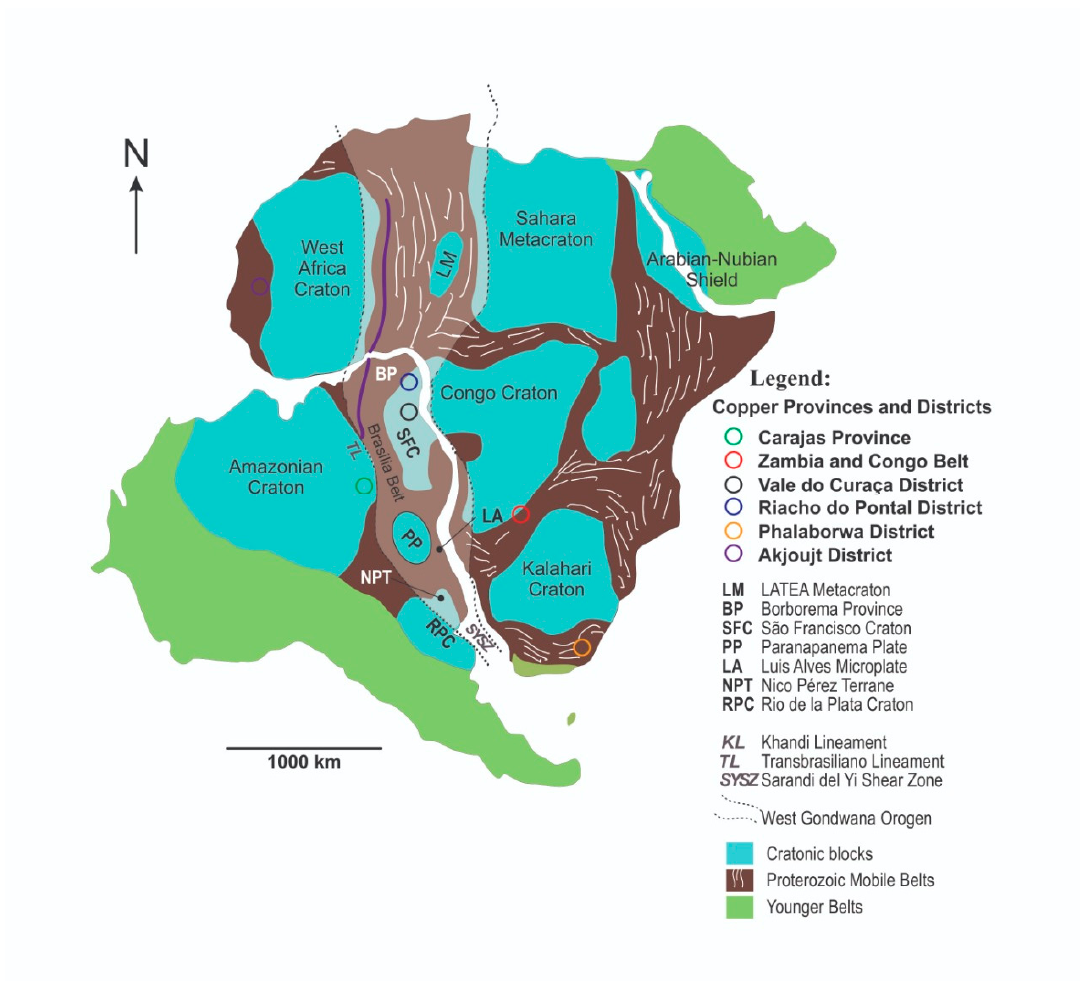
Figure 3. IOCG provinces and districts situated in Brazil and Africa: main crustal blocks and Neoproterozoic orogenic belts in South America and Africa, including locations of the West Gondwana Orogen (modified after [53–57]).